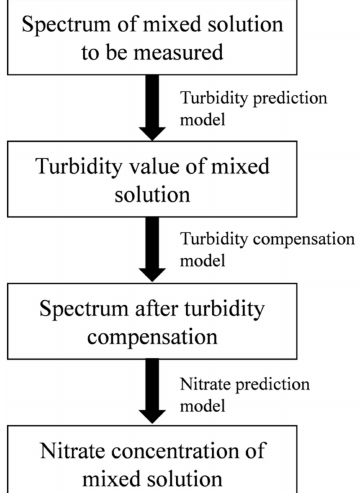
Figure 9. The process for calculating the nitrate